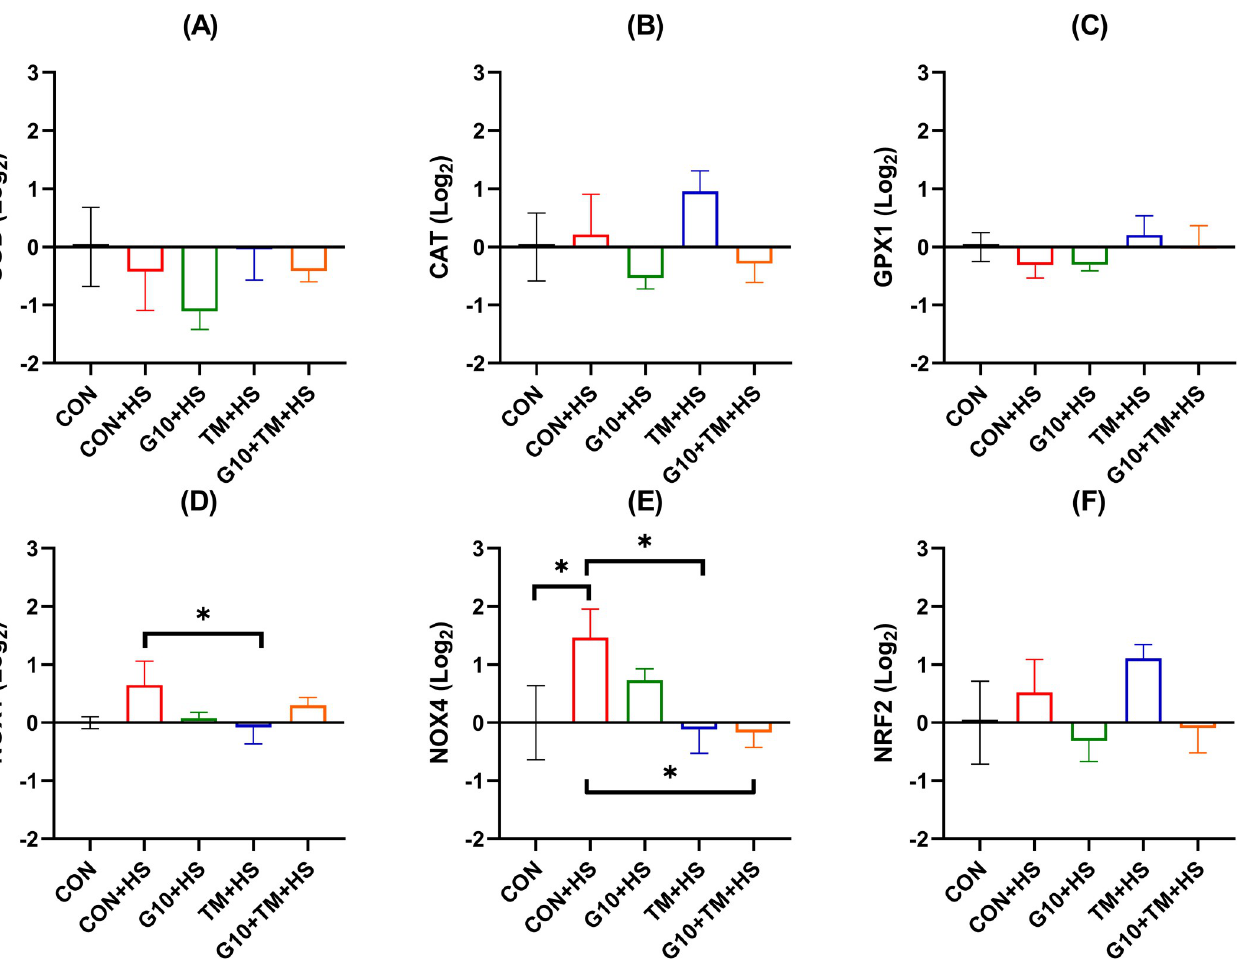
Fig 2. Effects of in ovo feeding of GABA and embryonic thermal manipulation on relative mRNA expression of hepatic SOD (A), CAT (B), GPx1 (C), NOX1 (D), NOX4 (E), and NRF2 (F) in broiler chickens exposed to cyclic HS. The treatments are described as follows: CON, chicks hatched from control eggs without in ovo injection and incubated at standard temperature; CON+HS, chicks hatched from control eggs without in ovo injection, incubated at standard temperature but exposed to HS; G10+HS, chicks hatched from eggs injected at 17.5 days of incubation with 0.6mL of 10% GABA dissolved in distilled water and exposed to HS; TM+HS, chicks hatched from thermally manipulated eggs exposed to 39.6˚C for 6 h daily from ED 10 to 18 and exposed to HS; G10+TM +HS, chicks hatched from eggs that received both previous treatments during incubation and exposed to HS. Data show mean ± SEM (n = 5). Results of the contrast analysis are indicated in the graph. Abbreviations: CAT, catalase; GPx1, glutathione peroxidase 1; NOX1, nicotinamide adenine dinucleotide phosphate oxidase 1; NOX4, nicotinamide adenine dinucleotide phosphate oxidase 4; NRF2: Nuclear factor erythroid 2-related factor 2; SOD, superoxide